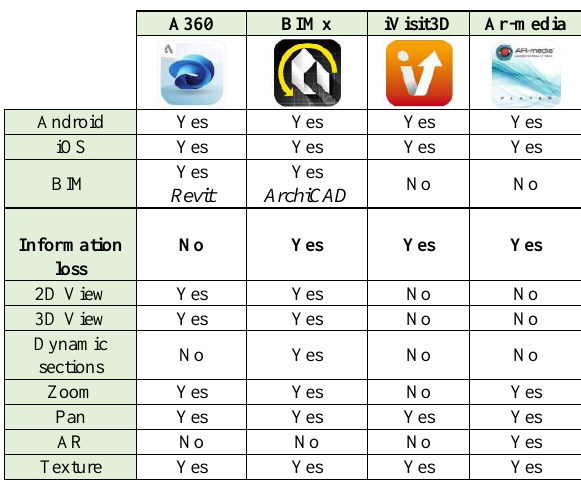
Table 1. Comparison of the four applications.